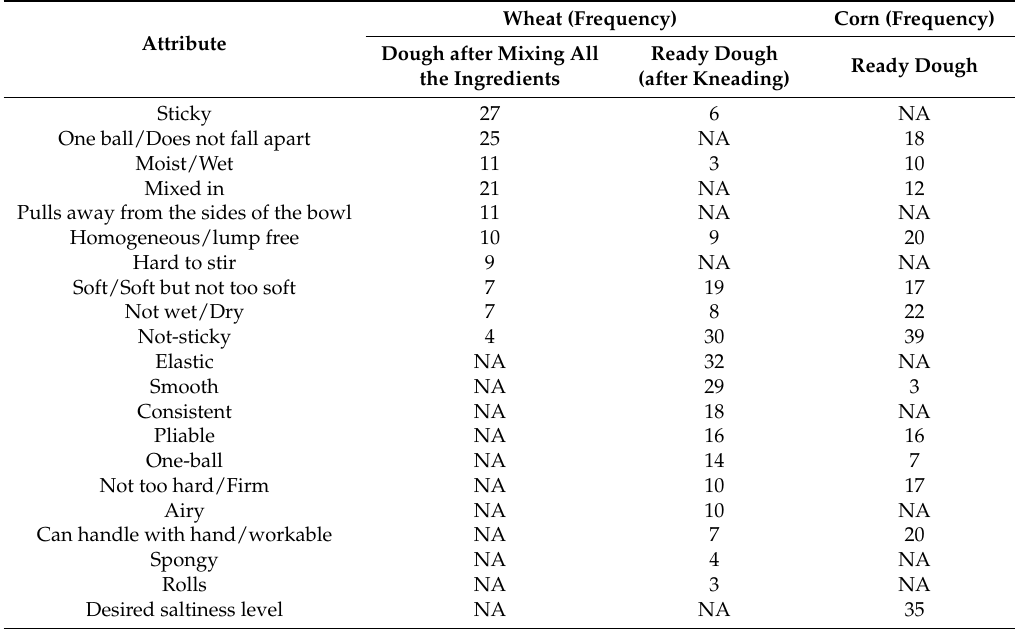
Table 8. Attributes and terms used by 43 wheat dough preparers and 50 corn dough preparers to describe a ready